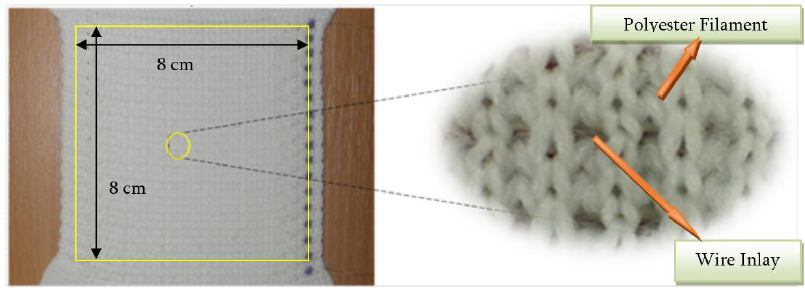
Figure 2. A TSF sample of 8 cm × 8 cm sensing area along with a magnified view of the knit structure [6].